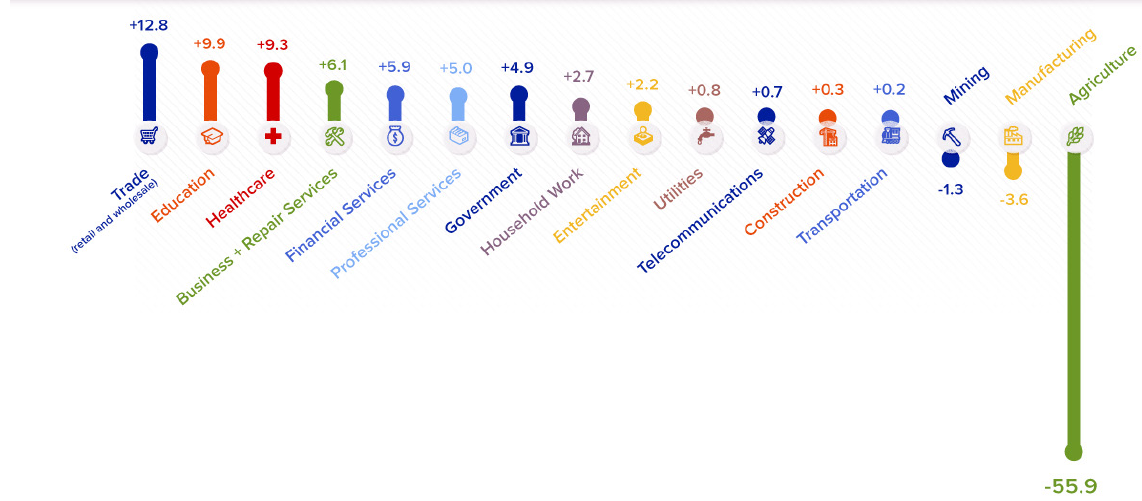
Figure 8. Employment share change in 1850–2015,